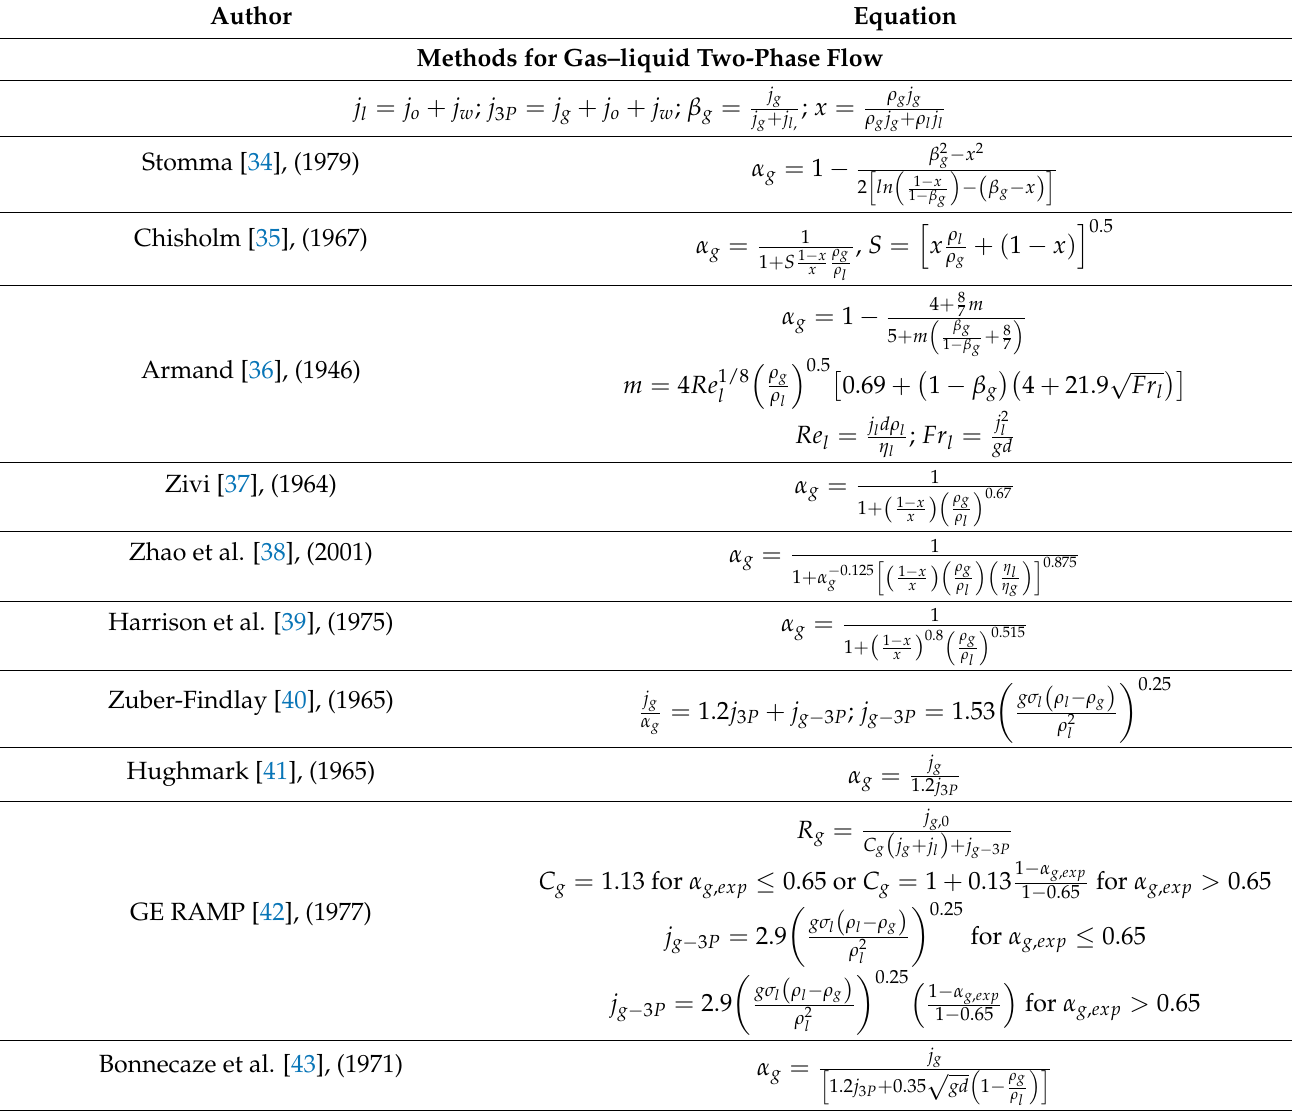
Table 6. Equations applied for the calculation of the void fraction in downward three-phase gas–liquid–liquid flow (vertical pipes).